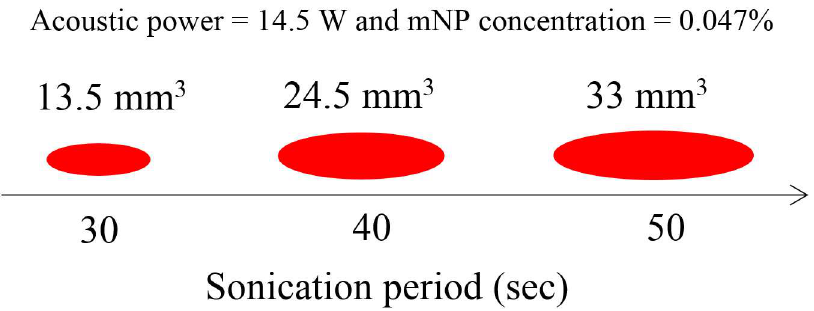
Fig 12. Lesion volume for a sonication period of 30, 40, and 50 sec for a mNP concentration of 0.047% and acoustic power of 14.5